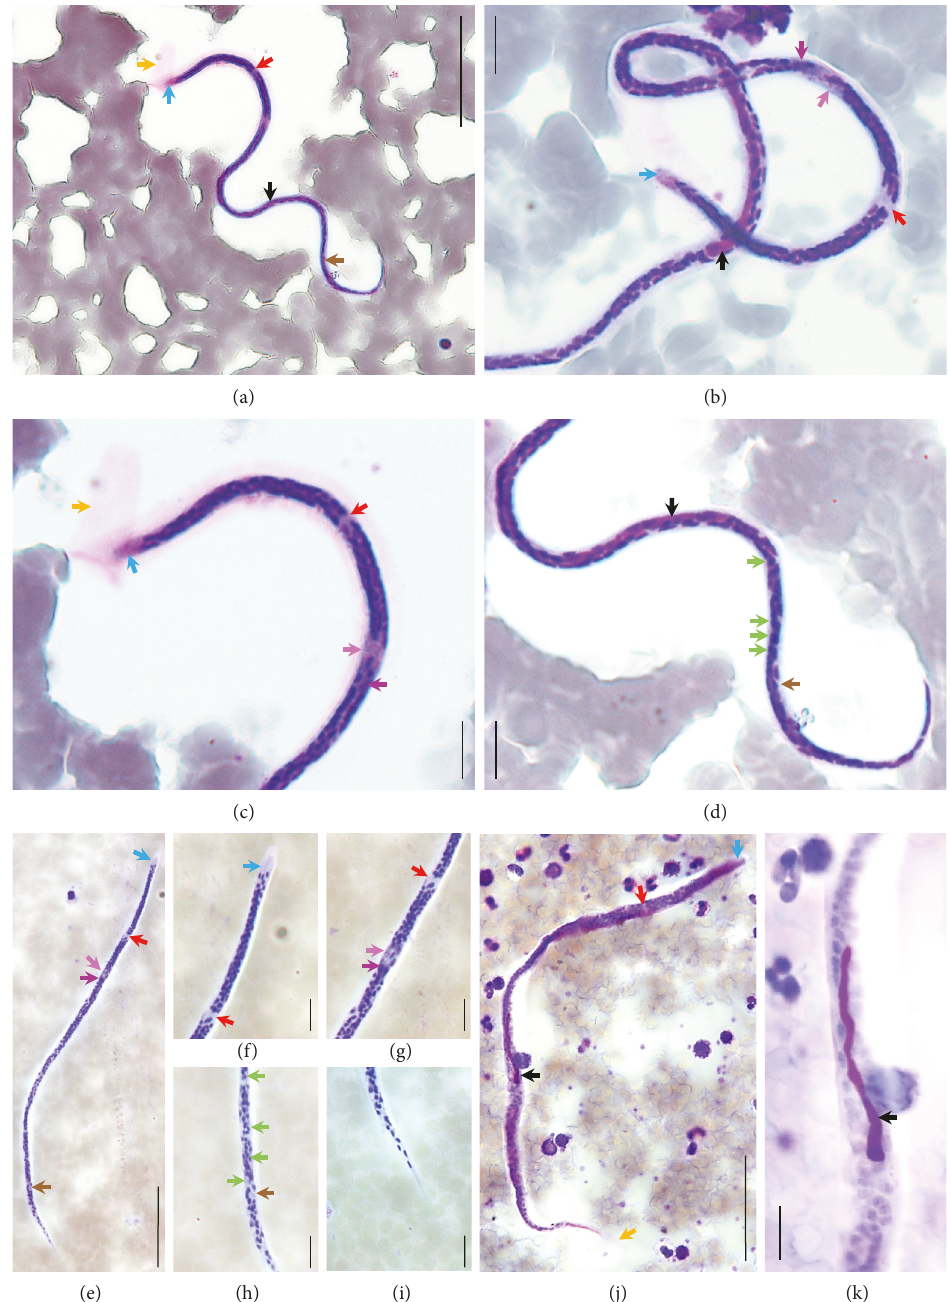
Figure 1: Microphotographs of Wuchereria bancrofti microfilaria in blood smears. (a–d) Thin blood films; (e–k) thick blood films; (a, e, j) full size microfilaria; (b) head and body details; (c, f) head details; (d) body and tail details; (g, h) body details; (i) tapered tail tip details free of terminal nuclei; (k) detail of the inner body. Coloured arrows represent sheath (orange), cephalic space (blue), nerve ring (red), excretory pore (pink), excretory cell (purple), inner body (black), germinal cells (green), and anal pore (brown) across the different pictures. Scale bars: (a, e, j) = 50 𝜇 m; (b–d, f–i, k) = 10 𝜇